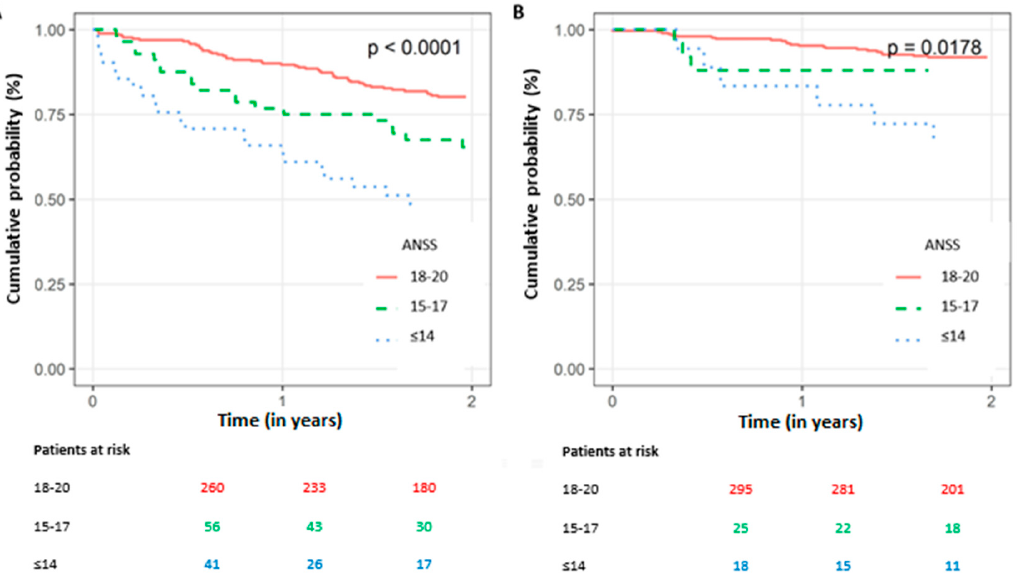
Figure 4. Kaplan–Meier survival curve for all-cause mortality over time in high vs. low clinical risk patients by admission Norton scale score. ( A ) High-clinical-risk patients: ≥ 70 years old and/or baseline serum creatinine values ≥ 1.5 mg/dL. p value < 0.0001. ( B ) Low-clinical-risk patients: <70 years old and baseline serum creatinine values < 1.5 mg/dL. p value = 0.0178. Numbers reflect patients at risk. ANSS, admission Norton scale score.